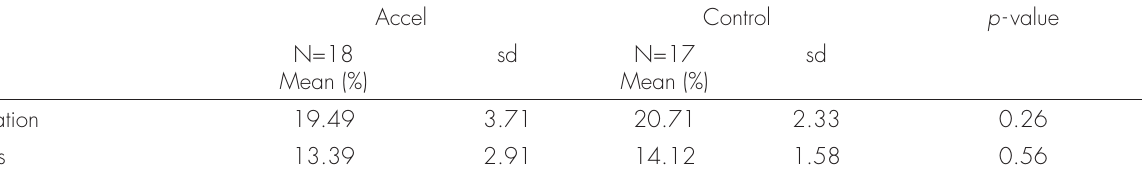
Table III. Comparison of treatment duration and number of visits per group.